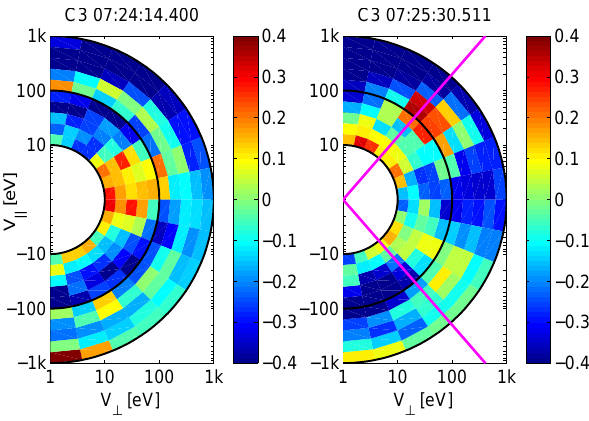
Fig. 6. Examples of the full 2-D distributions measured close to field maximum (left) and minimum (right). The distributions are plotted as relative deviation from the fitted background (f − f Af )/f Af . The locations where the two measurements were taken correspond to asterisks in the top panel of Fig. 4. The magenta lines in the second plot indicate the calculated critical pitch angle α c